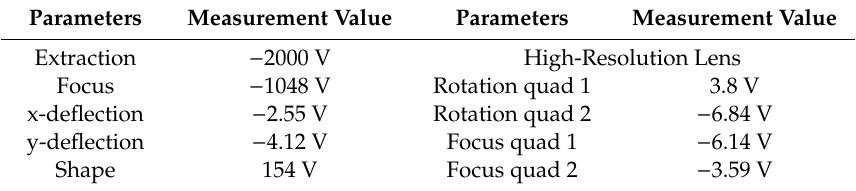
Table 4. Instrumental parameters used in the double-focus ICP-MS: value of ionic lens.